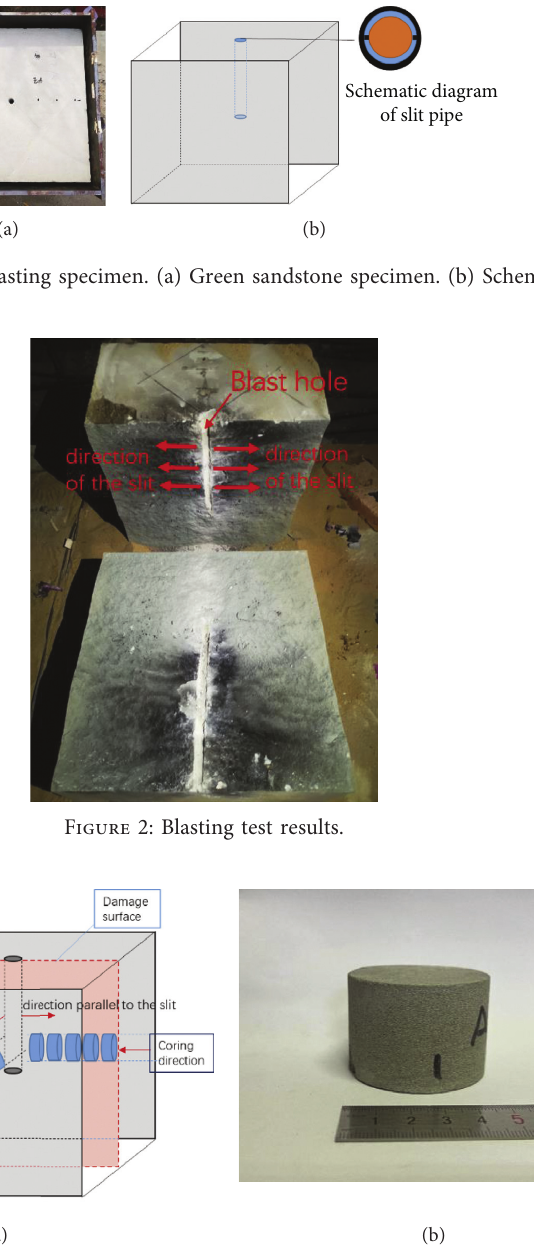
Figure 3: Schematic diagram of the sample preparation process. (a) Schematic diagram of coring. (b) Schematic diagram of the test